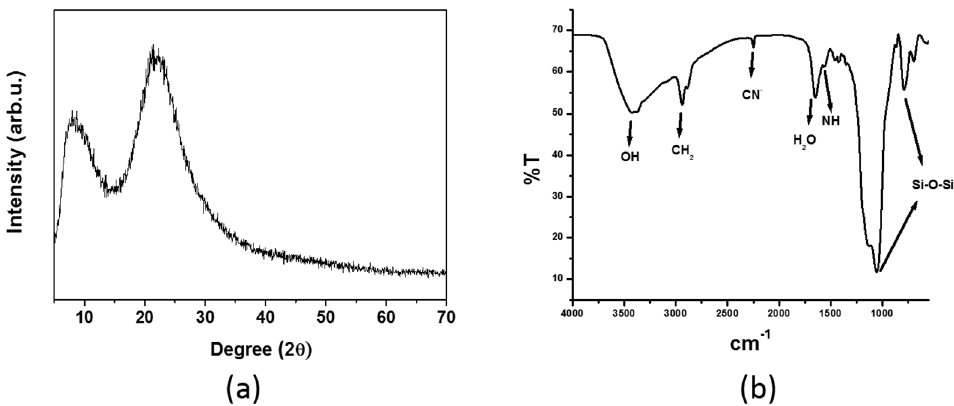
Figure 3. ( a ) XRD of hybrid silica monolith containing cyanopropyl and aminopropyl groups. ( b ) FTIR spectrum of hybrid silica monolith containing cyanopropyl and aminopropyl groups.